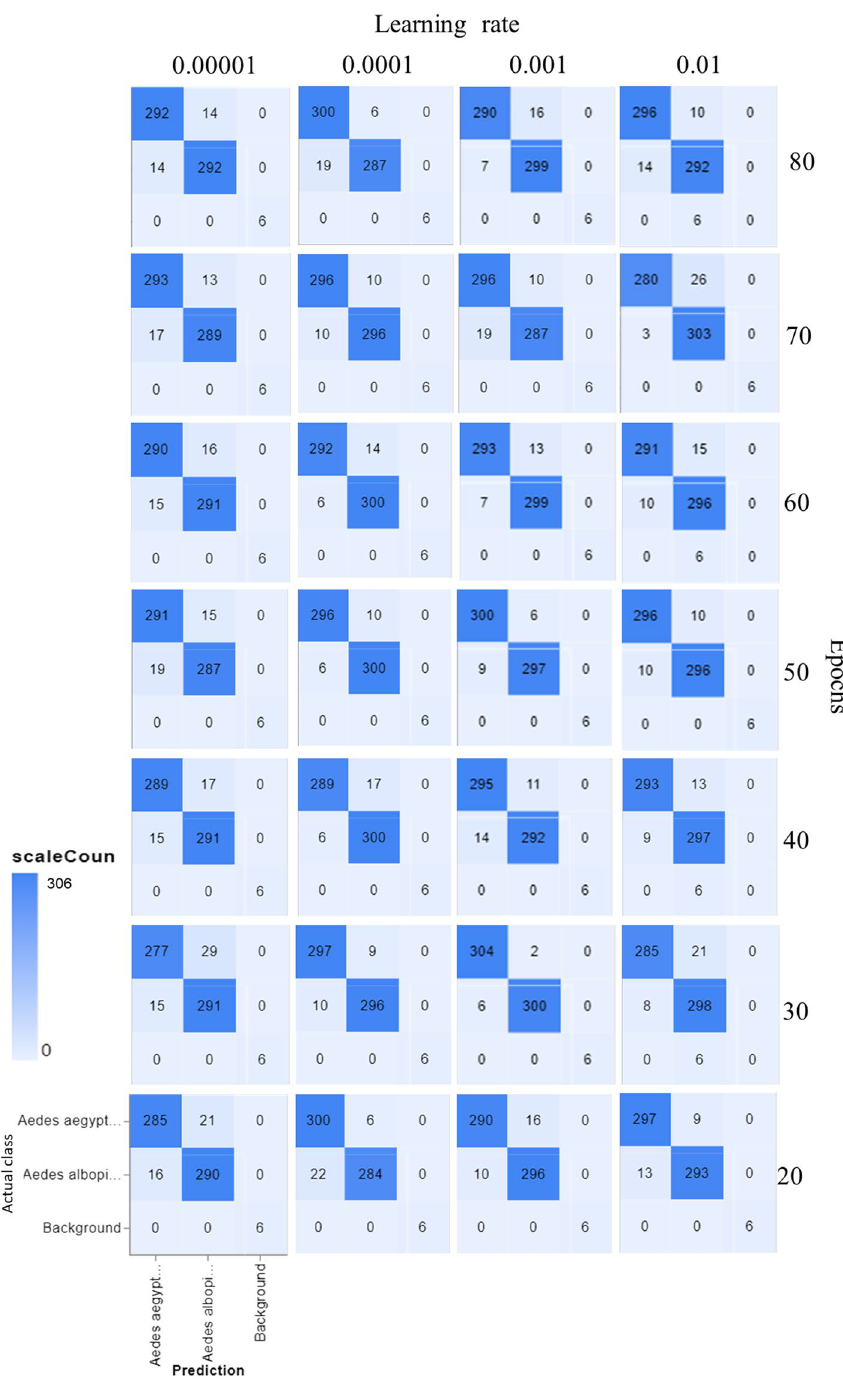
Figure 5. Confusion matrix of the proposed model with different epochs (vertical) and learning rate (horizontal): For the individual confusion matrix, the y-axis "actual class" refers to the ground-truth labels in the dataset, and the x-axis "prediction" refers to the model’s